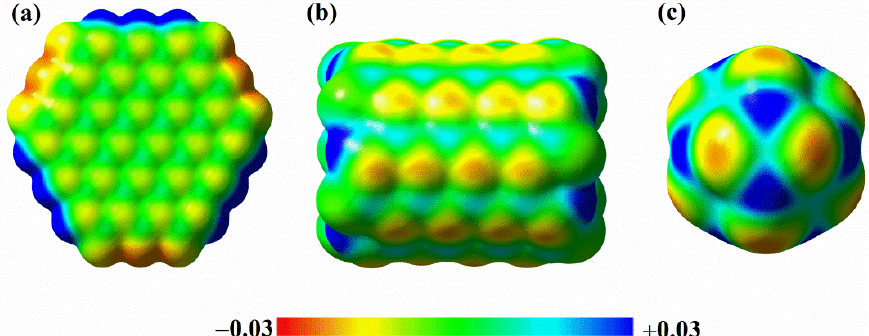
Figure 3. Molecular surface electrostatic potential of BN nanosheets ( a ), BN nanotubes ( b ), and BN nanocages ( c ) (electron density: 0.001 electrons/bohr 3 ).